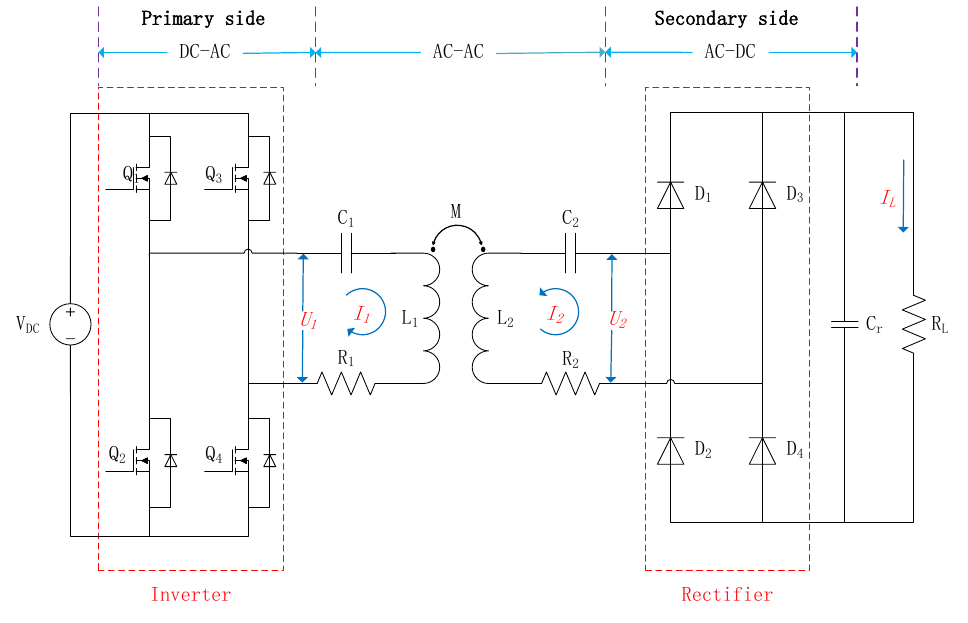
Figure 2. S-S-compensated WPT circuit.